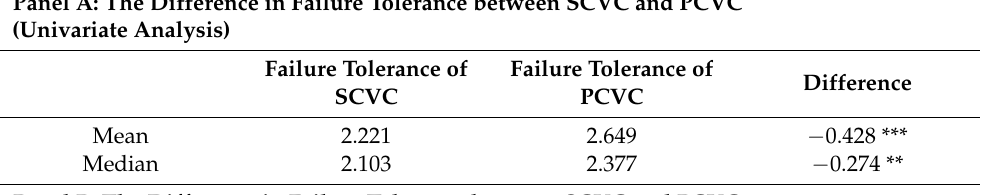
Table 7. Test of tolerance for failure hypothesis: second-stage OLS model: innovation of startups. Panel A: The Difference in Failure Tolerance between SCVC and PCVC (Univariate Analysis)